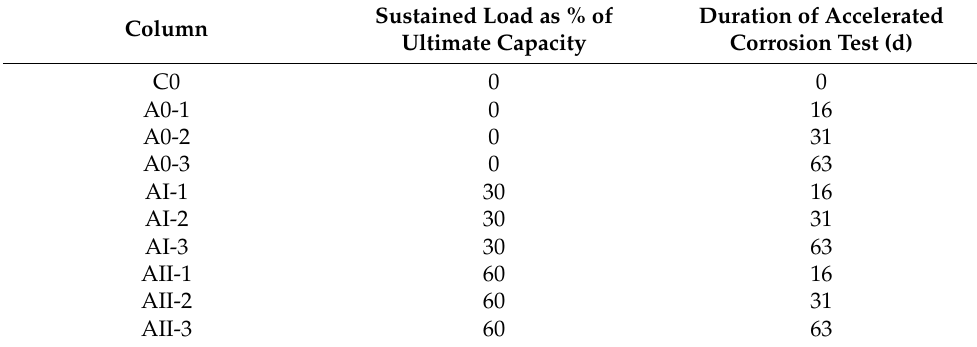
Table 2. Experimental program.